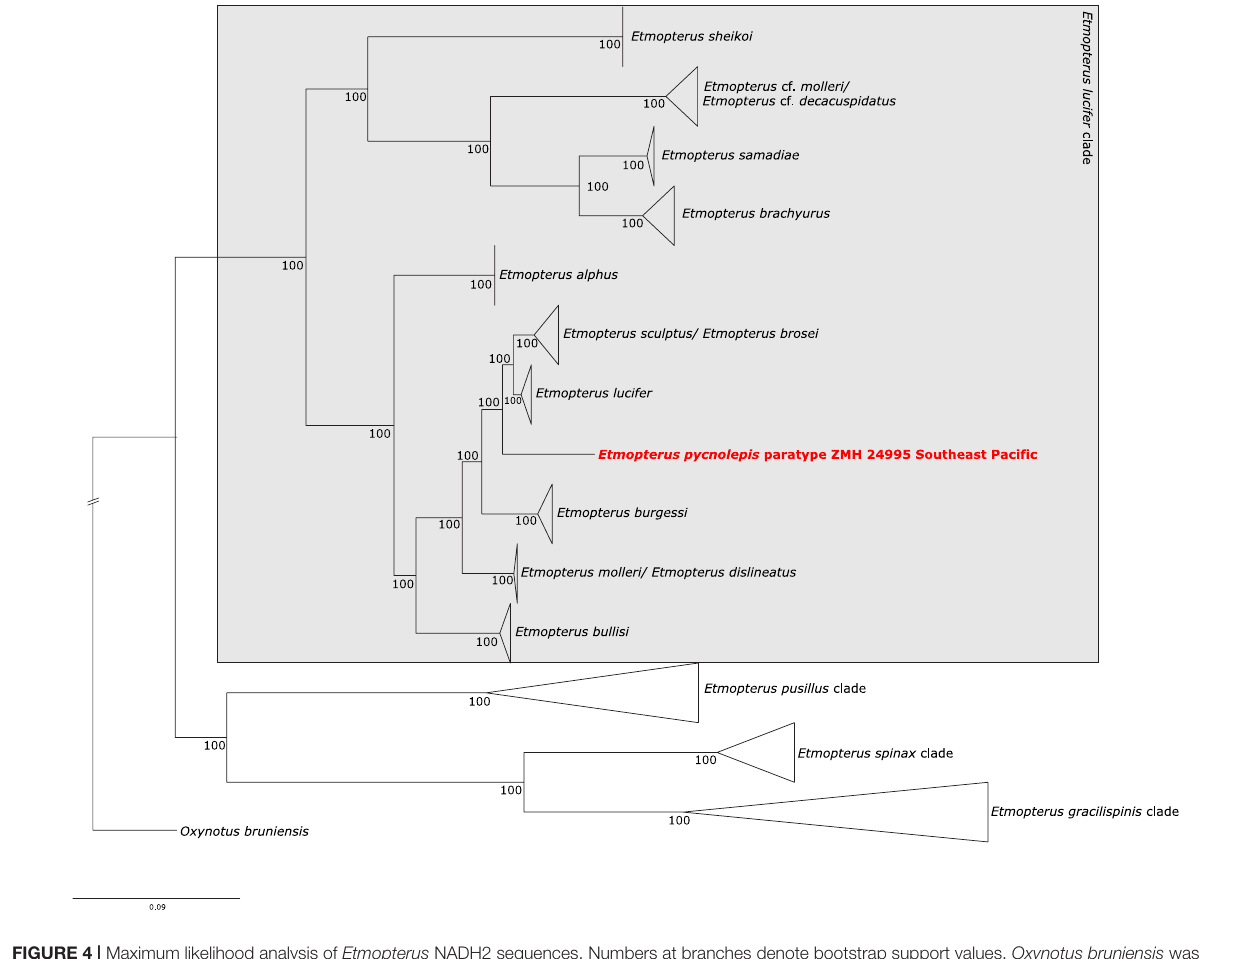
both species due to the phylogenetic placement of the E. litvinovi paratype sequence in the E. benchleyi clade and a very small K2P distance between both species.